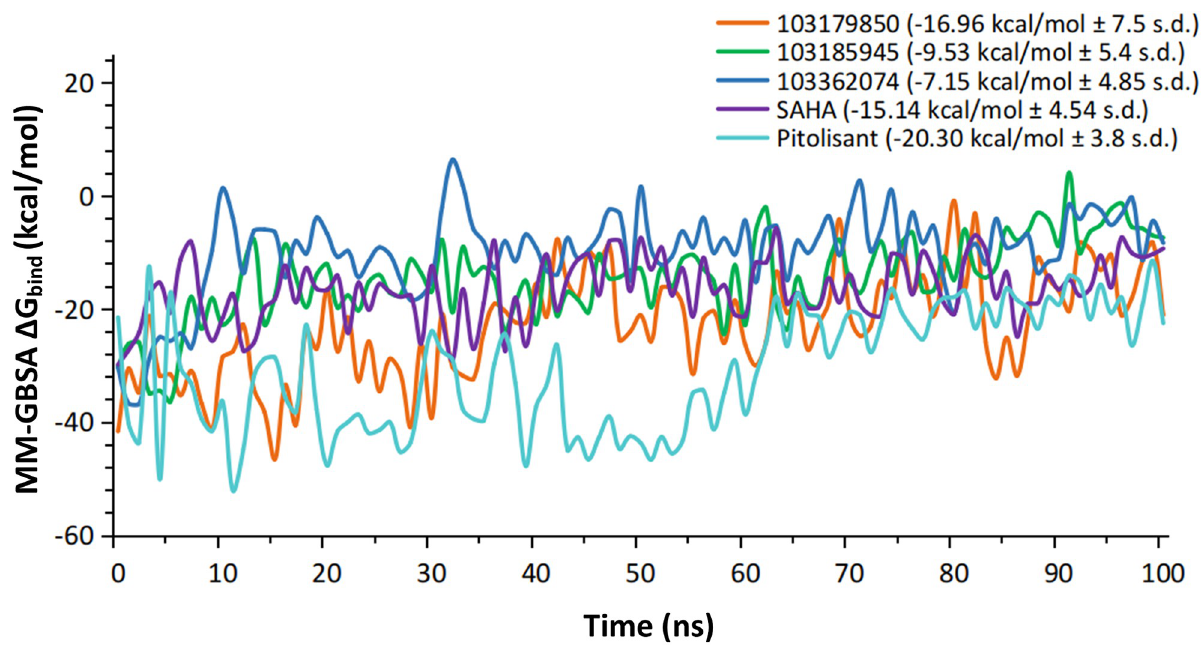
Fig 11. Time series plot of MM-GBSA Δ G bind values of HDAC2 trajectory frames at 1ns interval; Average values (in parenthesis) are approximated for relatively equilibrated frames of 60ns and beyond.